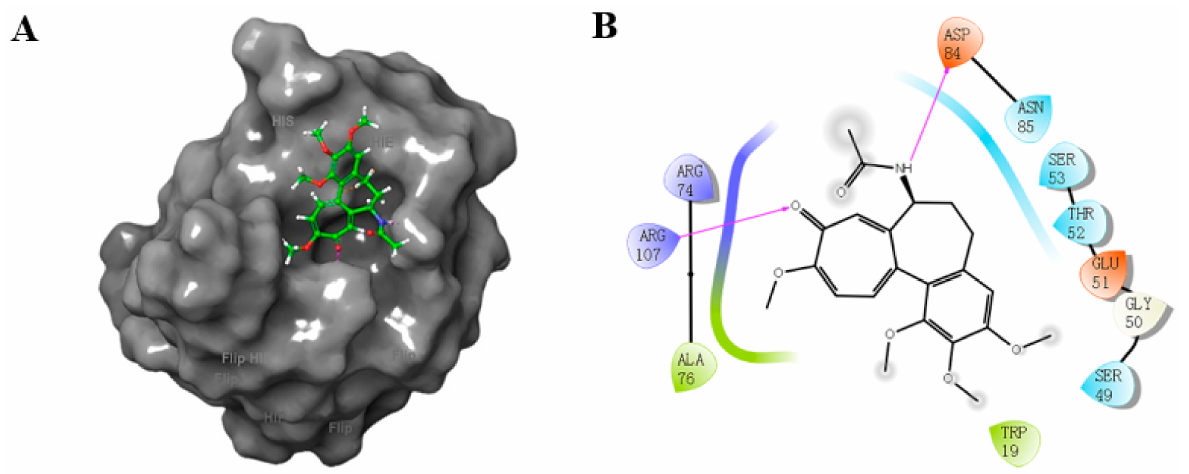
Figure 4. 3D ( A ) and 2D ( B ) diagram illustrating interaction between ZO-1 and COL. Gray region: ZO-1, green region: COL. Purple arrow: hydrogen bond, purple: charged (positive), green: hydrophobic, blue: polar, white: